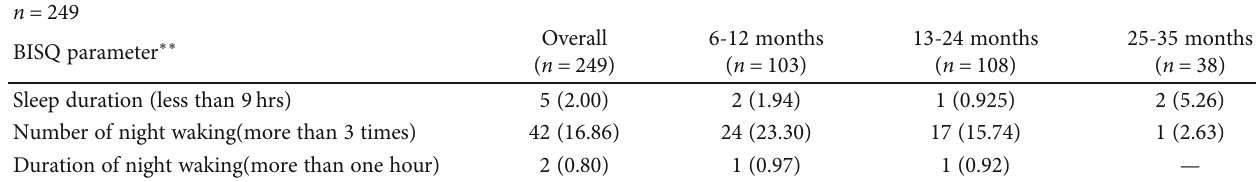
Table 4: Children with sleep problems according to BISQ.